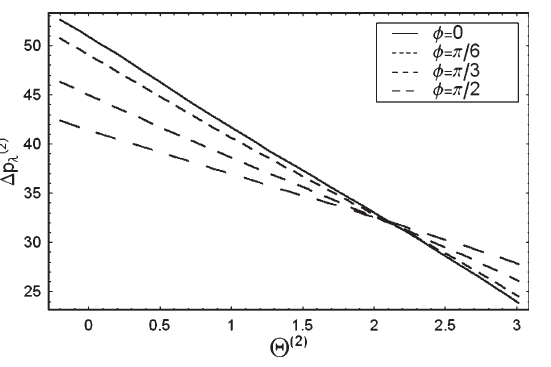
with a for λ (max)